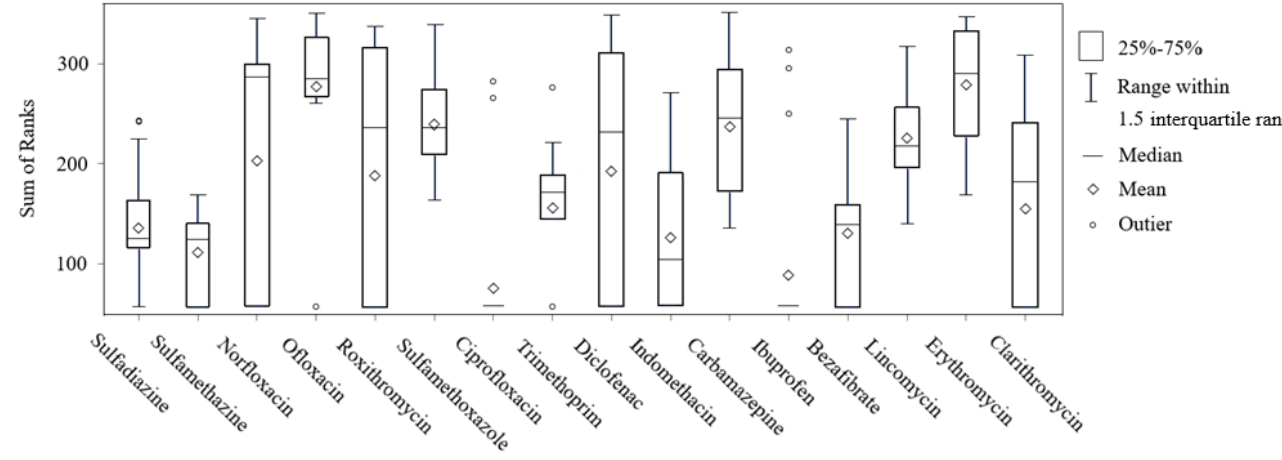
Figure 2. The rank sums (indicates the occurrence of a PPCP) of PPCPs in the Daqing River Basin.